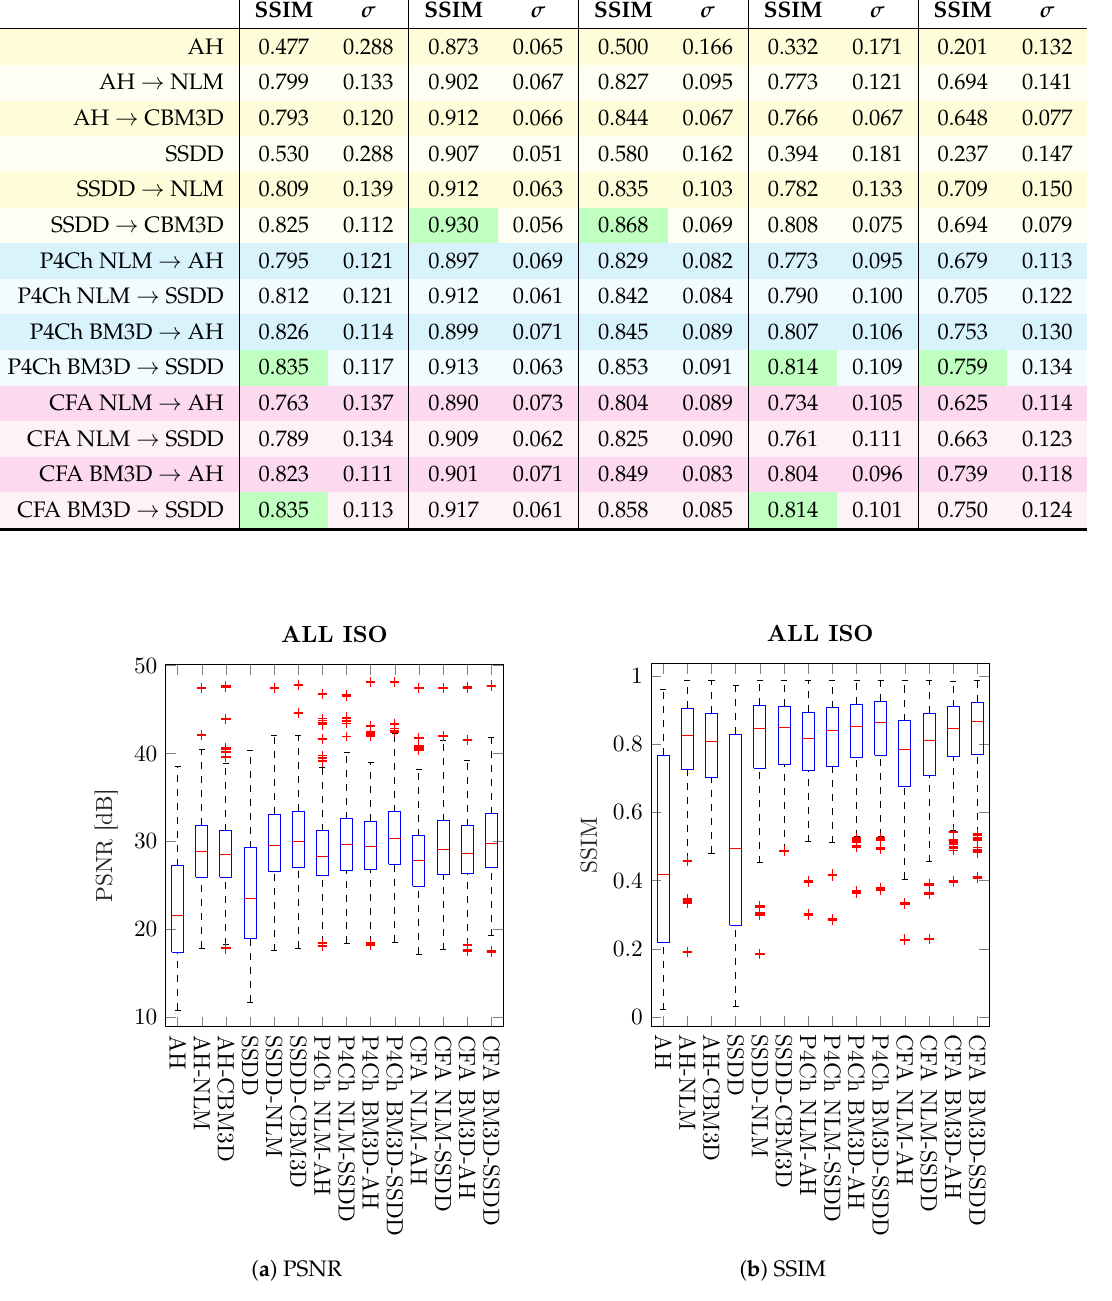
Figure 12. Box plots of quality coefficients for all images and noise